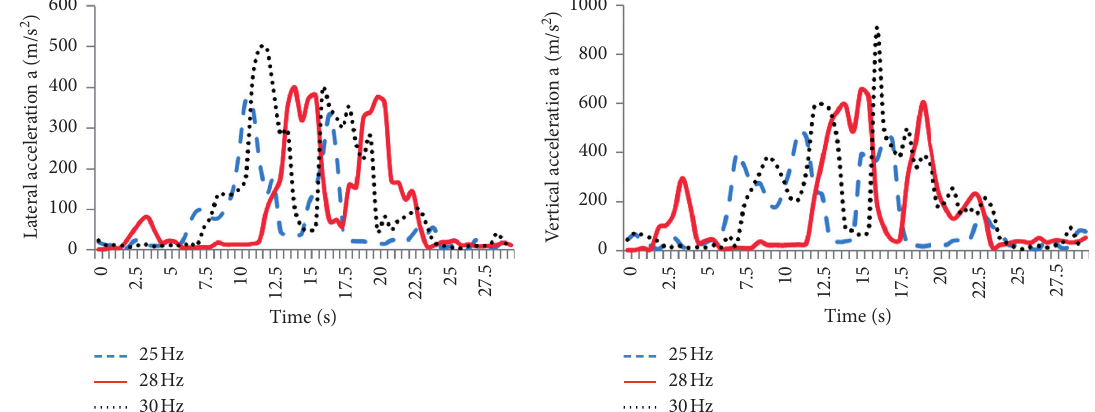
Figure 8: The envelope of acceleration of rail under different vibration frequencies.